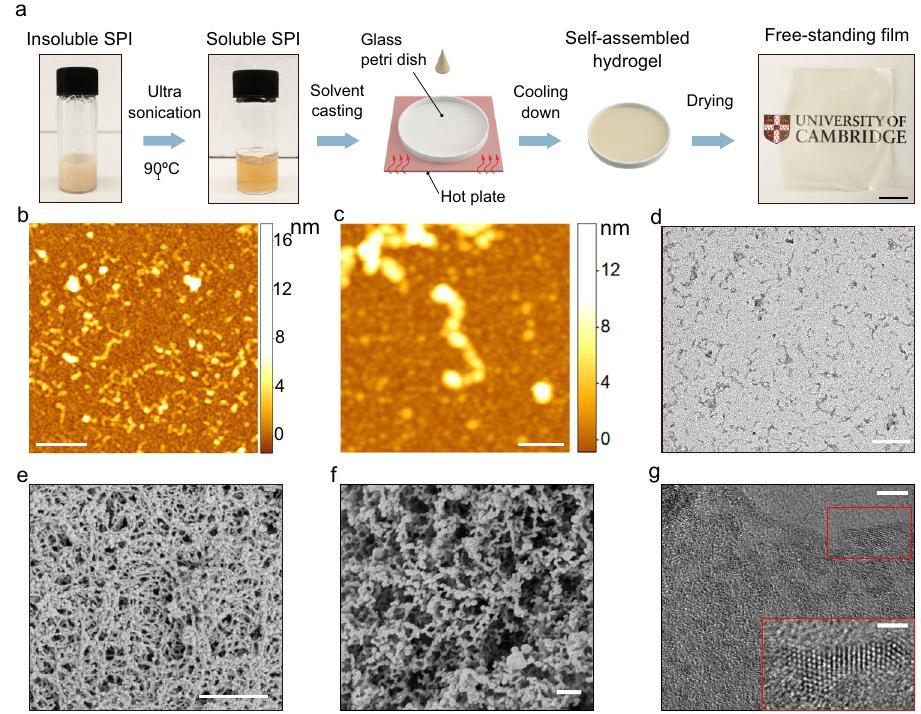
Fig. 1 Solvation of plant proteins and generation of fi lms through molecular self-assembly. a A translucent aqueous soyprotein isolate (SPI) solution (10 w/v% SPI, 30 v/v% acetic acid) was obtained via ultrasonication treatment at elevated temperature (90 °C) for 30 min. The resultant SPI solution was cast on a pre-heated glass Petri dish. Upon cooling, a translucent hydrogel was formed. Following evaporation of the solvent, a free-standing fi lm was obtained (scale bar 1 cm). b – d AFM images ( b , c ), and TEM image ( d ) of SPI fi brillar aggregates formed through the self-assembly process. Scale bars are 500 nm for b and d , and 100 nm for c . e SEM image of SPI hydrogel prepared through supercritical CO 2 drying. Scale bar is 500 nm. f cryo-SEM image of SPI hydrogel. Scale bar is 500 nm. g TEM image of β -sheet nanocrystals in dried SPI fi lm. Scale bars are 5 nm for the main image and 2 nm for the